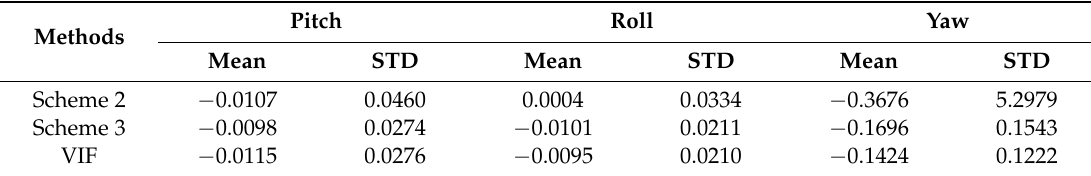
Table 8. The statistics of the alignment errors from 300 s to 400 s ( ◦